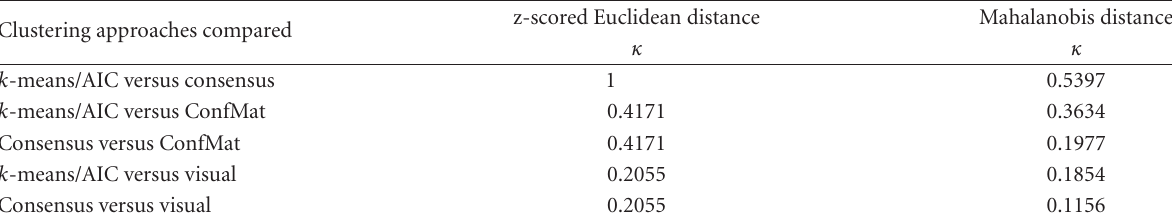
Table 2. Comparison of clustering methods and distance functions. The agreement between the sets of clusters resulting from the four clustering methods described in the text was measured using the κ test. The standard deviations of the statistic under the null hypothesis were estimated to range between 0.014 and 0.023 from multiple